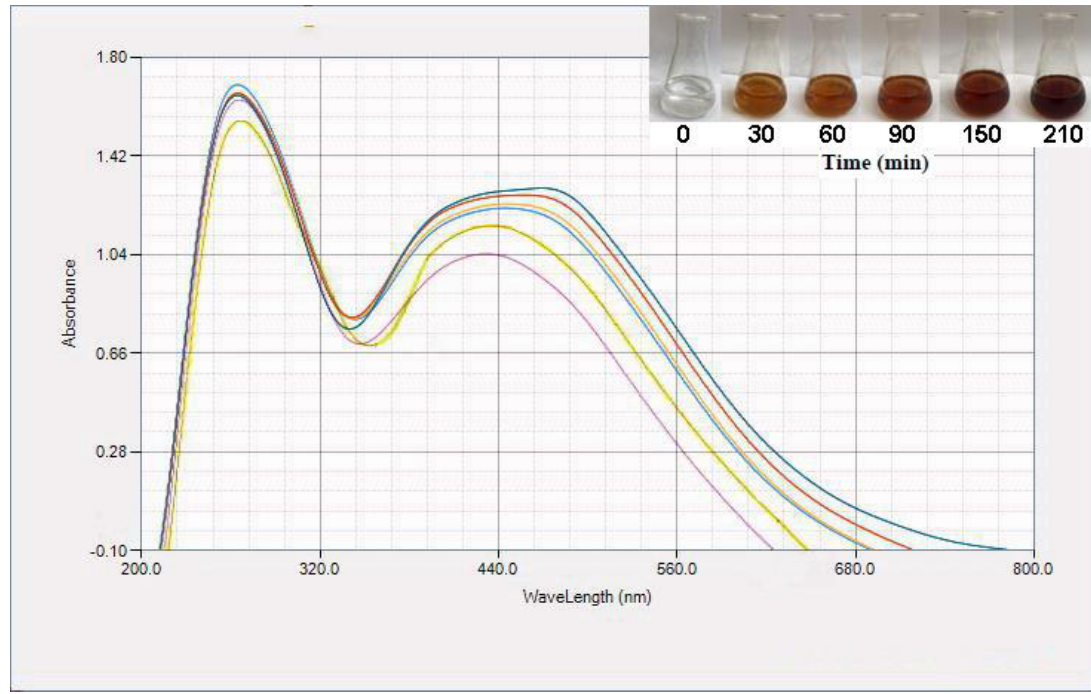
Figure 1. UV–Vis spectra of biosynthesized AgCl- NPs using aerial part extracts of the Pulicaria vulgaris plant at various times ( 15, 30, 60, 90, 150 and 210 min). Additionally, color changes of reaction mixtures are shown.